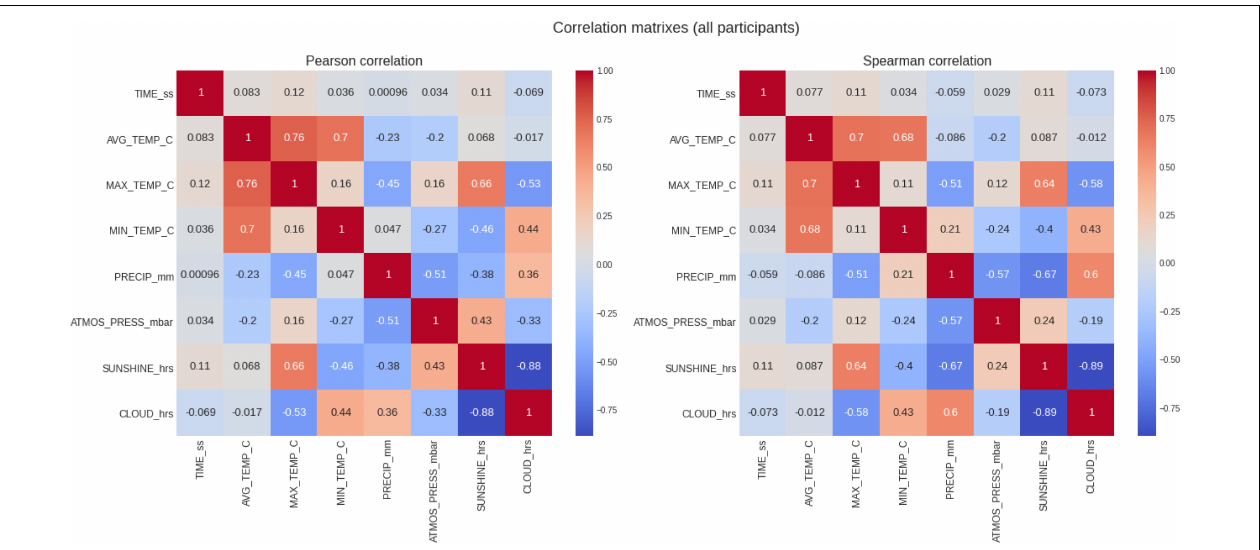
Frontiers in Physiology |